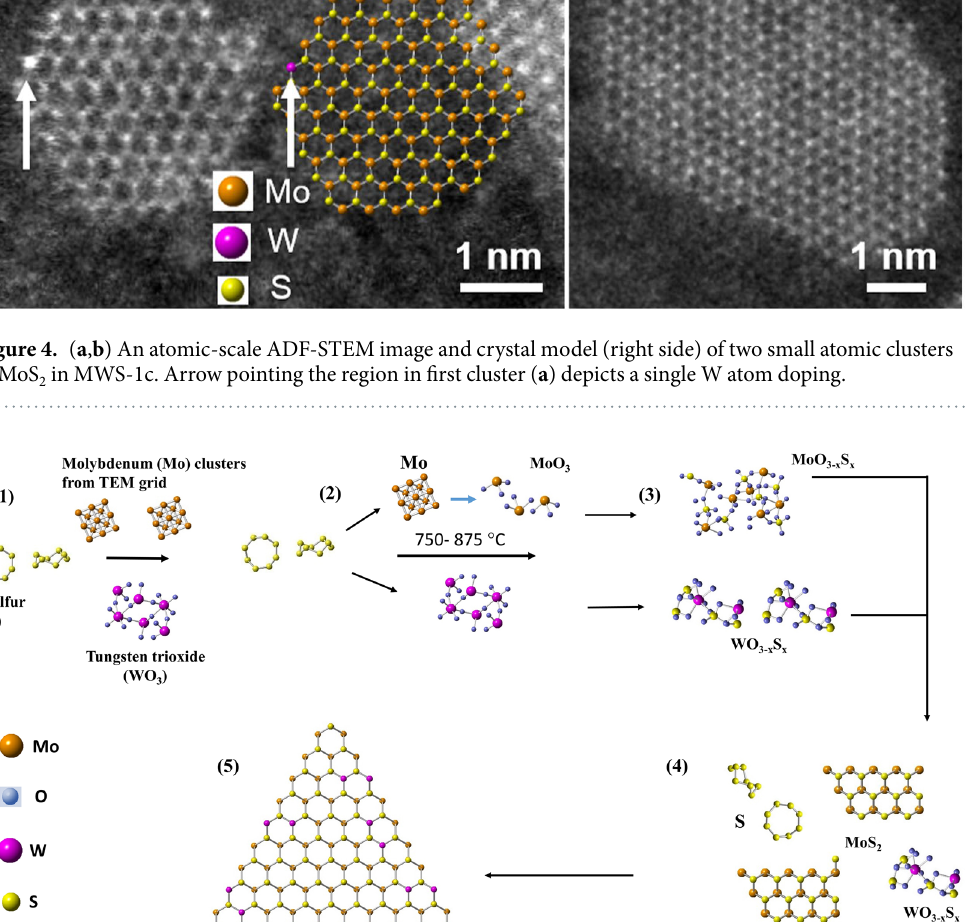
After sulfurization (in the case of MoS sample), Mo clusters possibly forms an amorphous alloy which possess octahedral or tetrahedral co-ordination 45,46 . Due to this complexity in its structure, it requires large energy to change its geometry to evolve as two-dimensional hexagonal network 45,47 . Speaking in terms of partial pressure environments, higher S partial pressure environment would lead to the fullerene structure, lower S partial pres- sure leads to oxy-sulfide particles 48 . In this case, promoter such as WO 3 in its reduced form W-O (x) /WS x O (3 − x) probably needed to reduce the complex structure as in the case of MoS and provides suitable S partial pressure environment to form two-dimensional hexagonal network of MoS 2 . In step 2, at the high temperatures between 825–875 °C, Mo get oxidized and forms thermally active MoO 3 structures together with Mo clusters which is not oxidized. Due to the differences in the surface free energy of graphene (around 46.7 mJ/m 2 ) 49 and Mo (around 2.92–3.34 J/m 2 ) 50 , metal atoms migrating on graphene is expected to form molecular clusters on graphene 51,52 , which is more reactive with sulfur and oxygen than the Mo atoms and W-O (x) clusters, and hence readily reacts with the incoming sulfur atoms (Step 3) 31,33 . The reductant